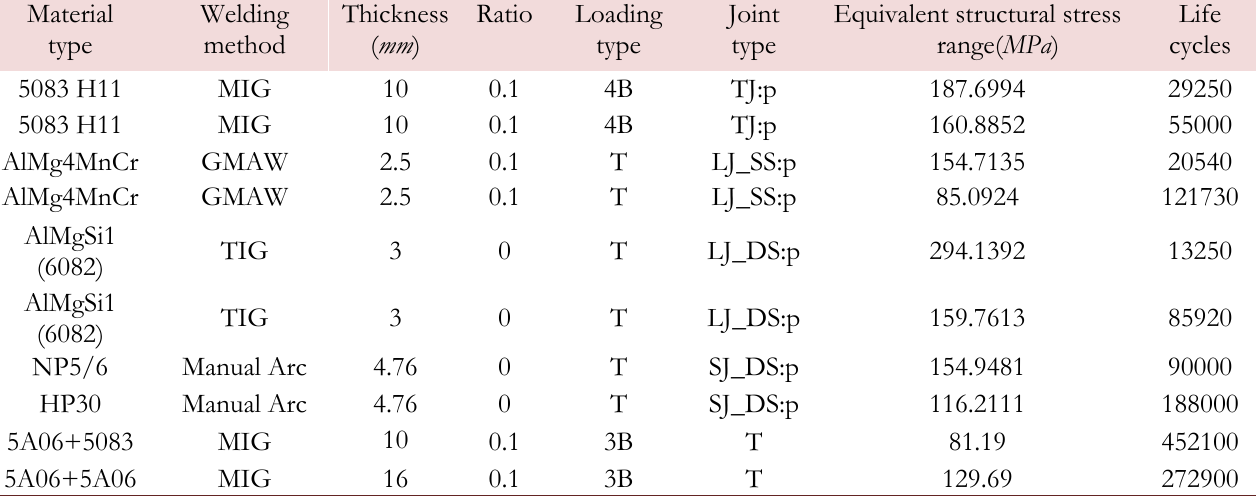
Table 9: Fatigue data of aluminum alloy welded joints.